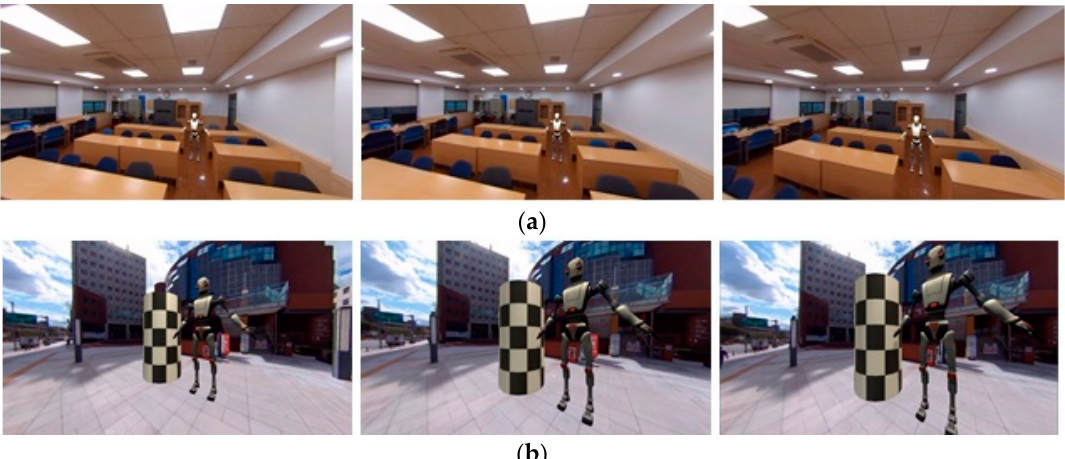
Figure 9. Results of pre-visualization: ( a ) indoor and ( b ) outdoor.